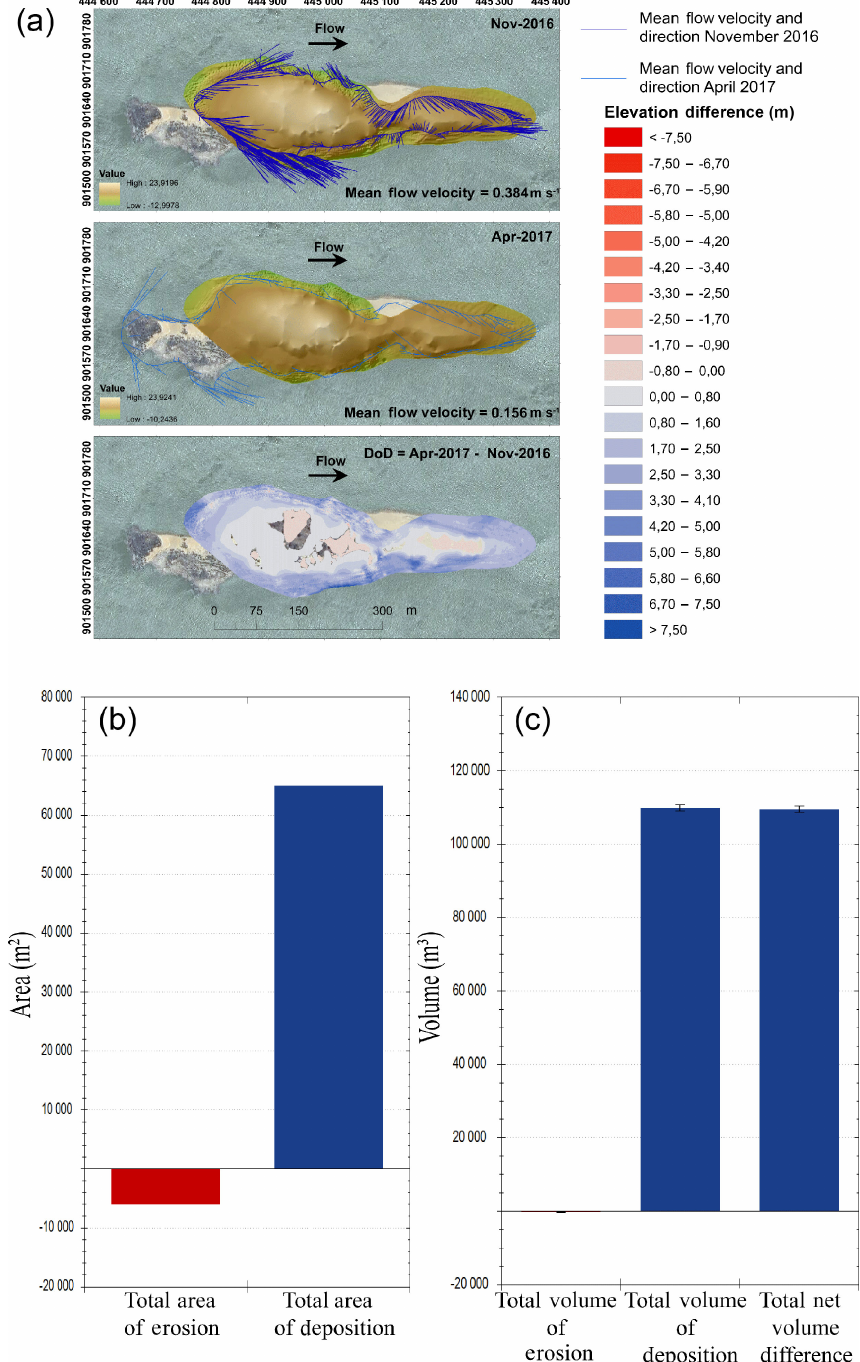
Figure 5. (a) DEMs on the two study dates and DoD over the mid-channel bar using LOD min = 0 . 01. In the DoD the red color represents erosion and the blue color deposition. (b, c) show the morphological changes in area (m 2 ) and volume (m 3